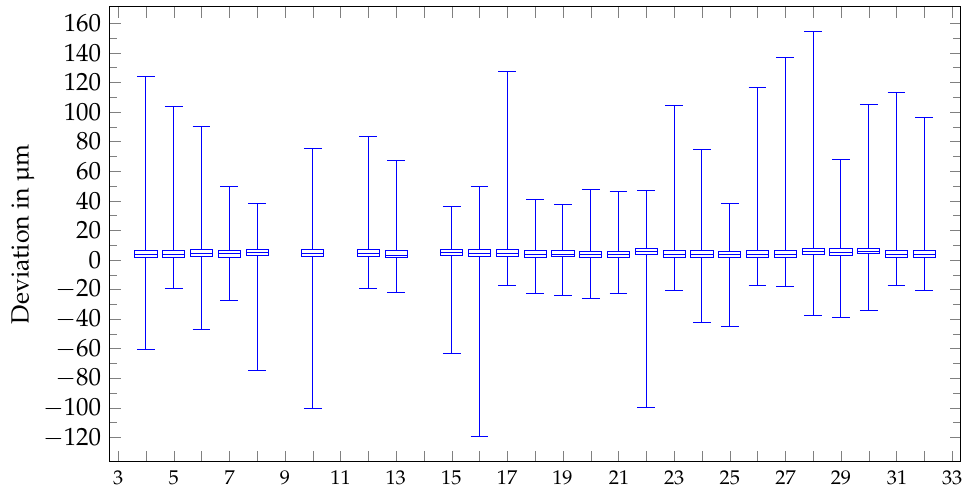
Figure 11. Box plots of the deviation analysis for the abstract swarf